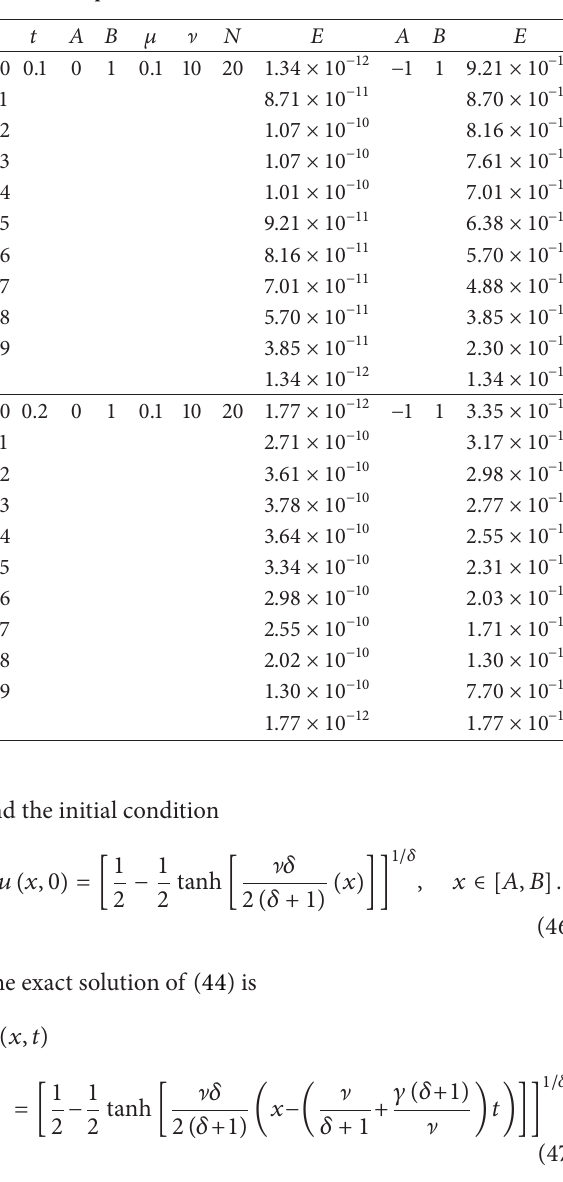
Table 6: Absolute errors with 𝛼 = 𝛽 = 1/2 and various choices of 𝑥, 𝑡 for Example